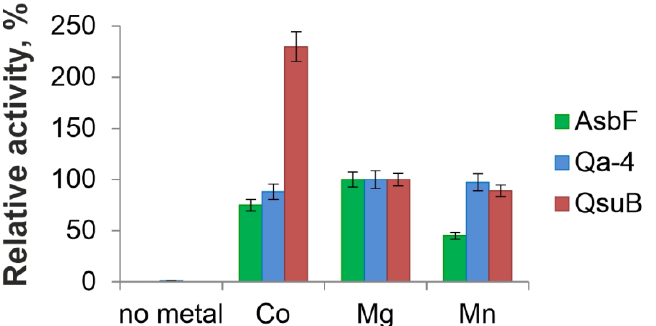
Figure 5. Metal dependency for direct conversion of DHS to 3,4-DHBA by AsbF, Qa-4, and QsuB. Relative DSD activities in the presence of divalent metals were normalized against the activities in the presence of 10 mM MgCl 2 . All activities were tested at physiological pH 7.5 and 20 °C.